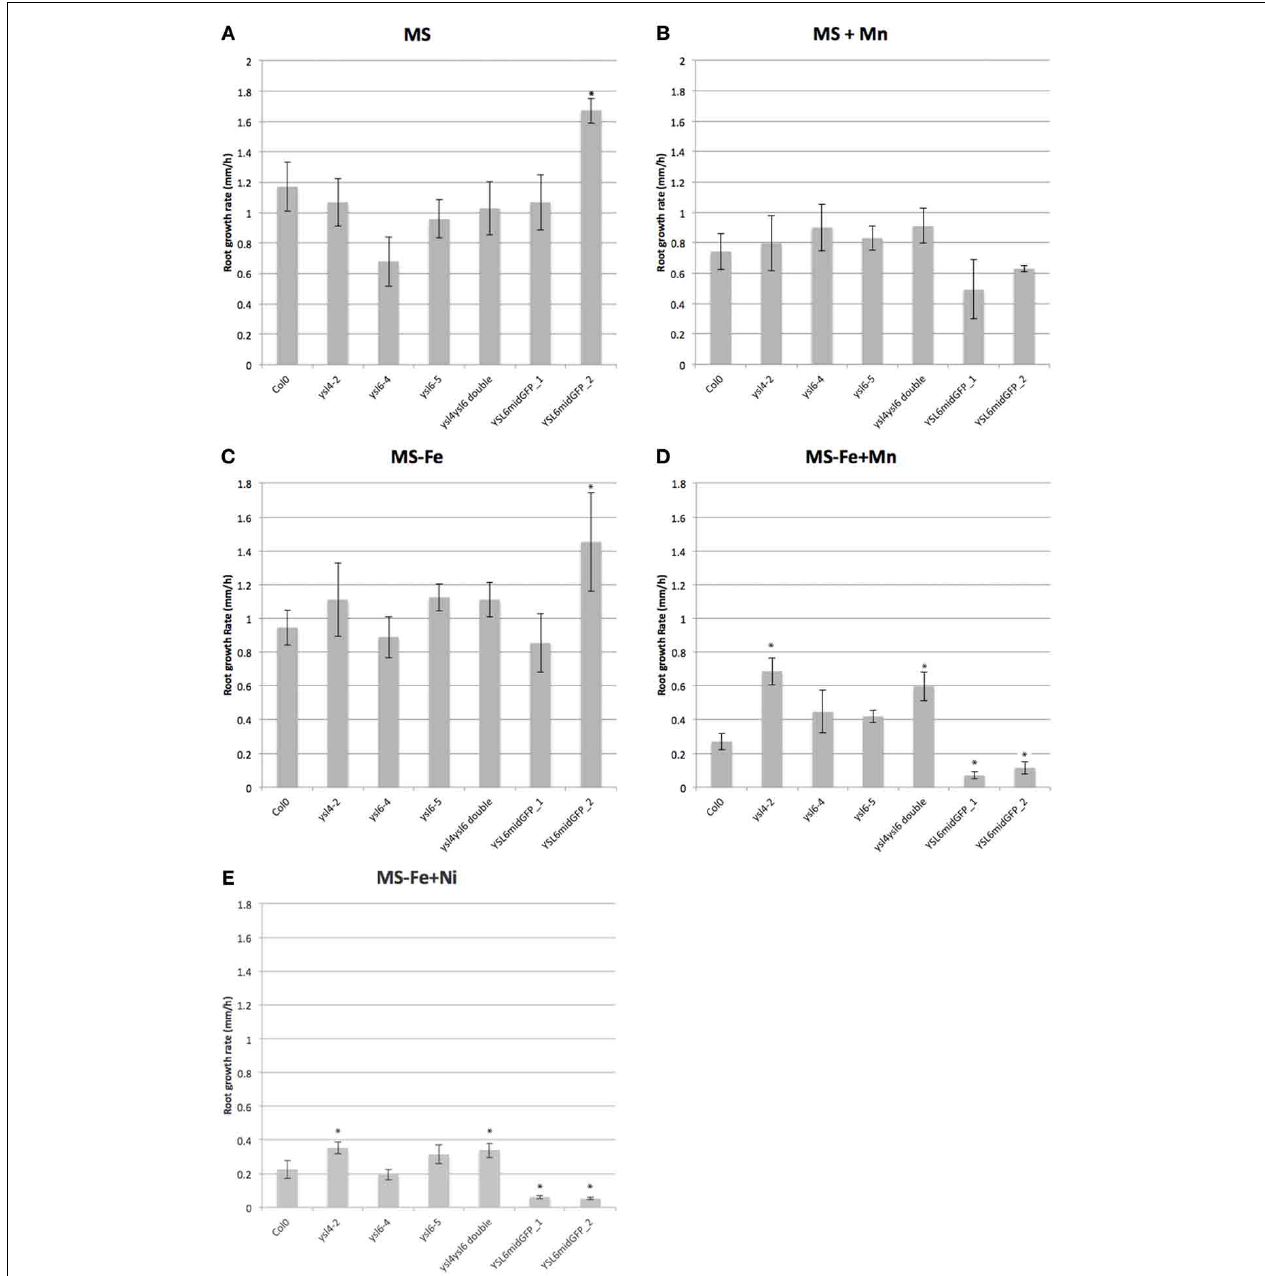
FIGURE 13 | Growth of mutants and YSL6-midGFP-OE plants on excess metals. Root growth rate during the 24h period between 24h and 48h post-germination is presented. Photographs of the plates were taken every 24h, and used to determine the growth rate for each 24h period (see Materials and Methods). Plants were germinated